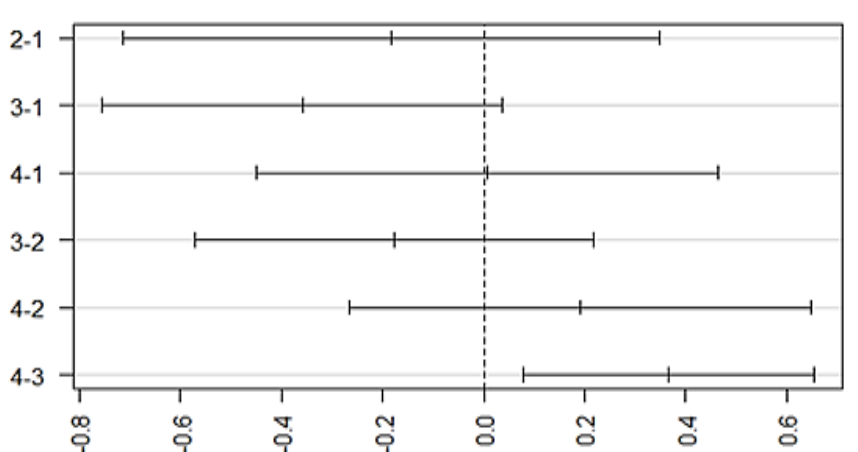
Figure 6. Post-hoc analysis representing differences in the mean levels of medication response regarding combined treatment therapy (ECT combined with antipsychotics). (Group-1) No response, (Group-2) temporary slow response, (Group-3) response followed by the worst episodic attacks, (Group-4) completely recovered. (2-1) Difference in response to medication between group 2 and 1, (3-1) difference in response to medication between group 3 and 1, (4-1) difference in response to medication between group 4 and 1, (3-2) difference in response to medication between group 3 and 2, (4-2) difference in response to medication between group 4 and 2, and (4-3) difference in response to medication between group 4 and 3.